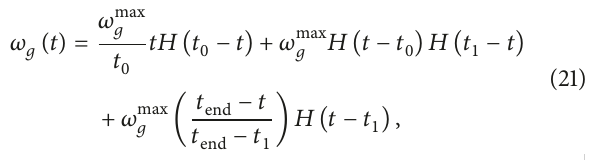
the input to the system and is prescribed as a ramp loading expressed by Heaviside